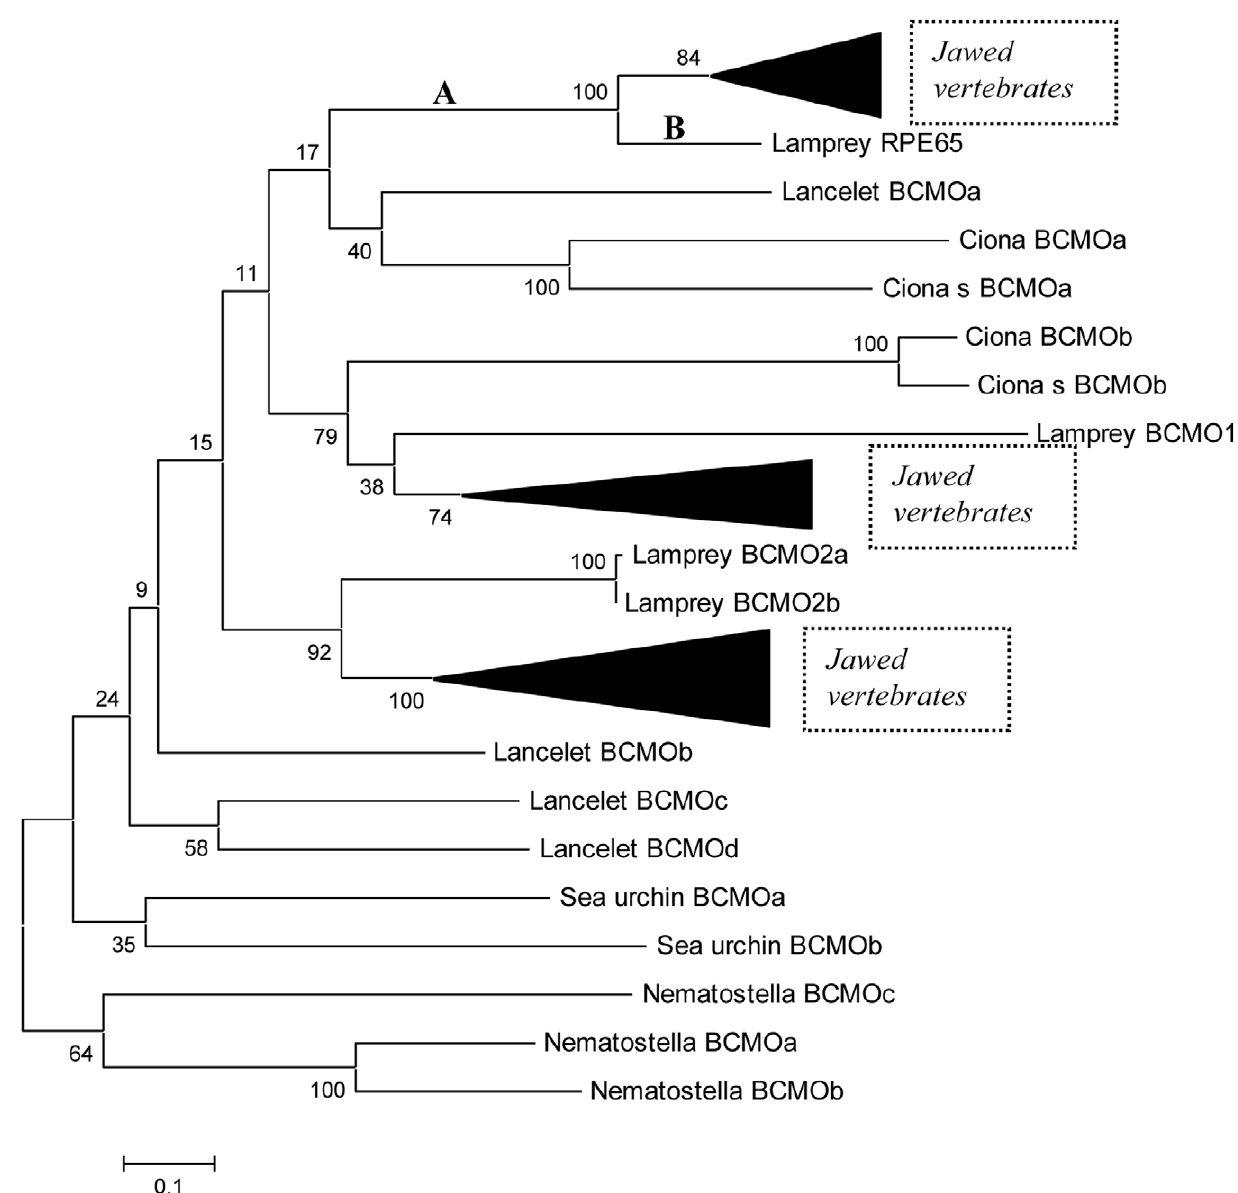
Figure 1. Maximum likelihood phylogenetic tree of the RPE65/BCMO superfamily (the WAG substitution model, the complete deletion option, the uniform rate of substitutions option as implemented in the MEGA5 program). The numbers for the interior branches refer to the bootstrap values with 1,000 pseudoreplicates. Ciona_s stands for Ciona savignyi .